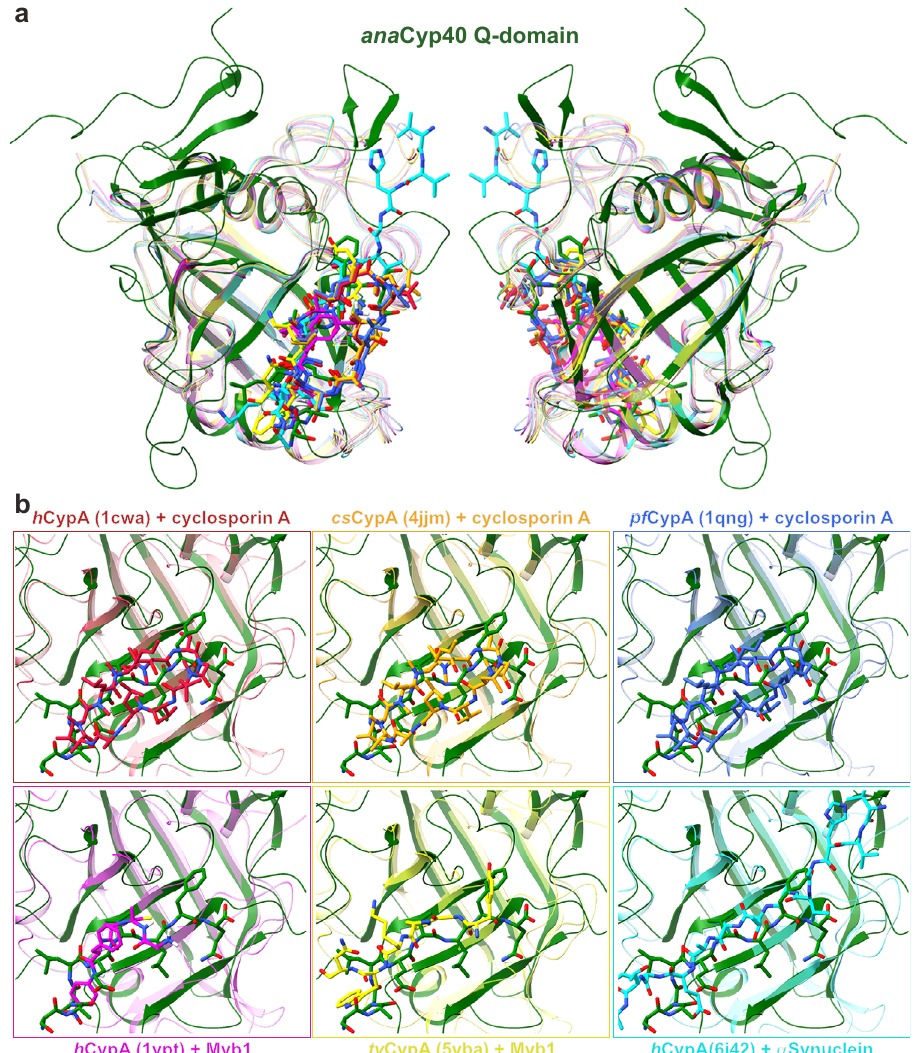
Fig. 8 Superimposition of the ana Cyp40 C-domain to single-domain cyclophilins. a The C-domain of ana Cyp40 is superimposed to single-domain cyclophilins identi fi ed by DALI 62 with an RMSD < 2 Å. Three of the compared domains (1cwa: 67 red; 4jjm: 125 orange; 1qng: 67 blue) have a bound cyclosporin A at the corresponding site of ana Cyp40, where the C-terminal peptide from the symmetry-related molecule is bound. The other three remaining domains (1vbt: 126 magenta; 4jjm: 125 orange; 6i42: 127 cyan) have at the same position peptides of different length. b Individual comparison of